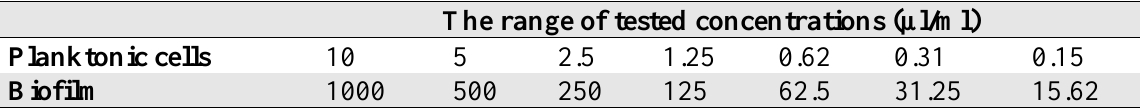
Table 2. Concentration ranges of tested